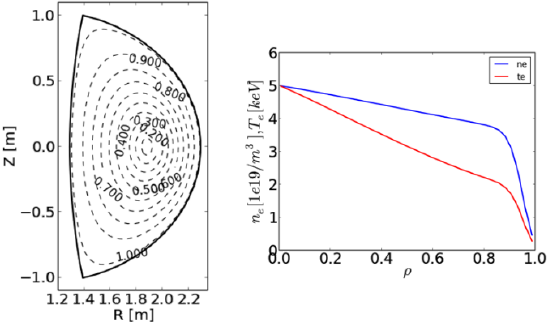
Fig. 2. The reference equilibrium and kinetic profiles.